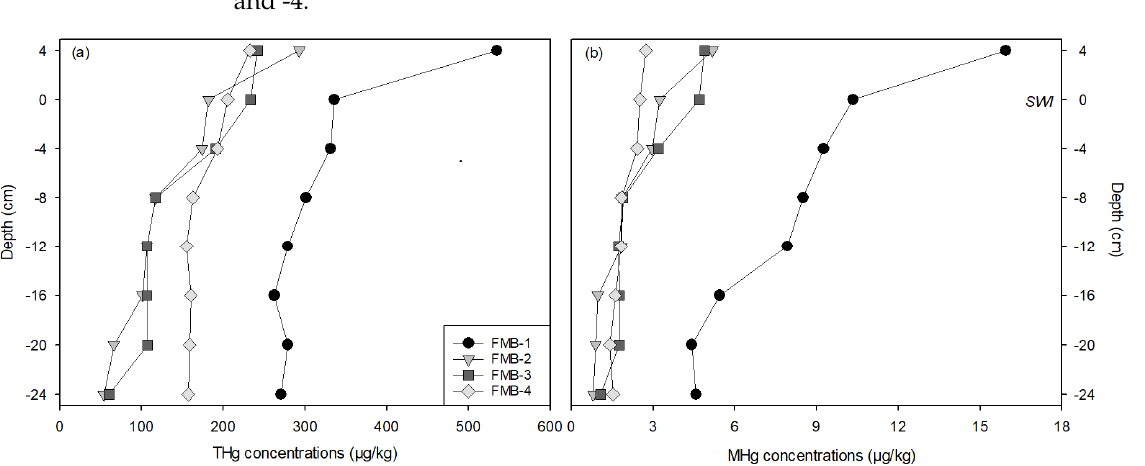
Figure 2. The depth profiles of total mercury (THg) ( a ) and methylmercury (MHg) ( b ) concentrations in the bulk sediment. The depth of 0 cm indicates the sediment–water interface.